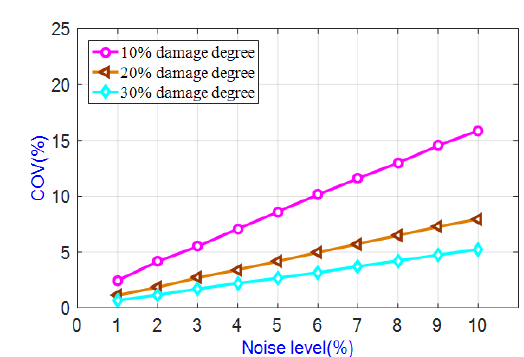
(cid:0) (cid:1) θ 0 / − θ 0 /θ 0 beam with various (cid:28)ber orientation angles.